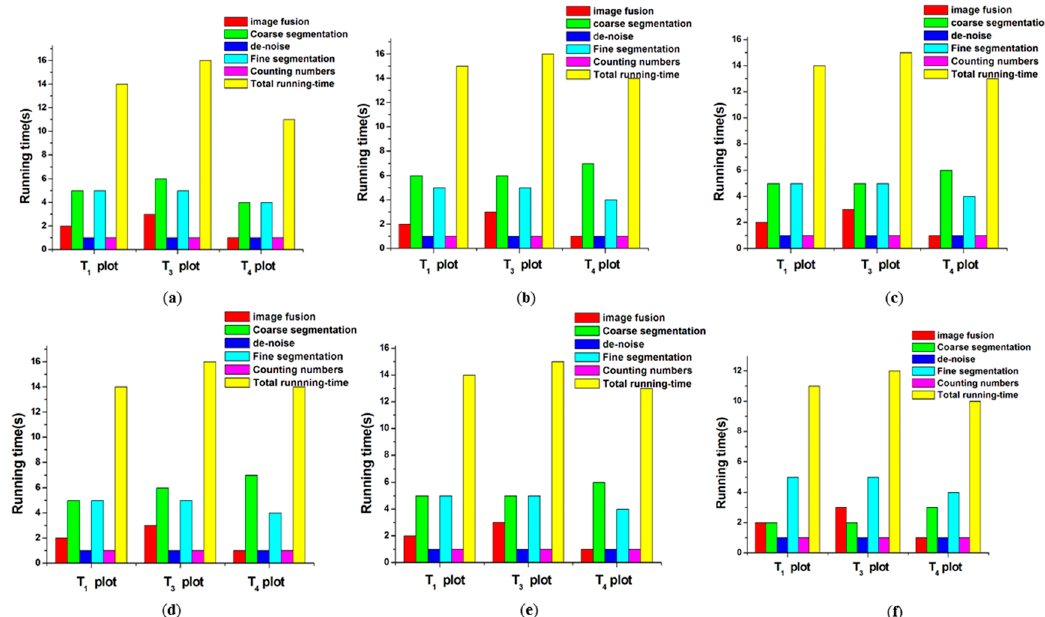
Figure 13. Comparison of running-times by using different coarse-segmentation methods. ( a ) Coarse- segmentation with Minimum cut; ( b ) Coarse-segmentation with Edge detection; ( c ) Coarse-segmentation with fuzzy clustering; ( d ) Coarse-segmentation with snake model; ( e ) Coarse-segmentation with region growth; ( f ) Coarse-segmentation with proposed method